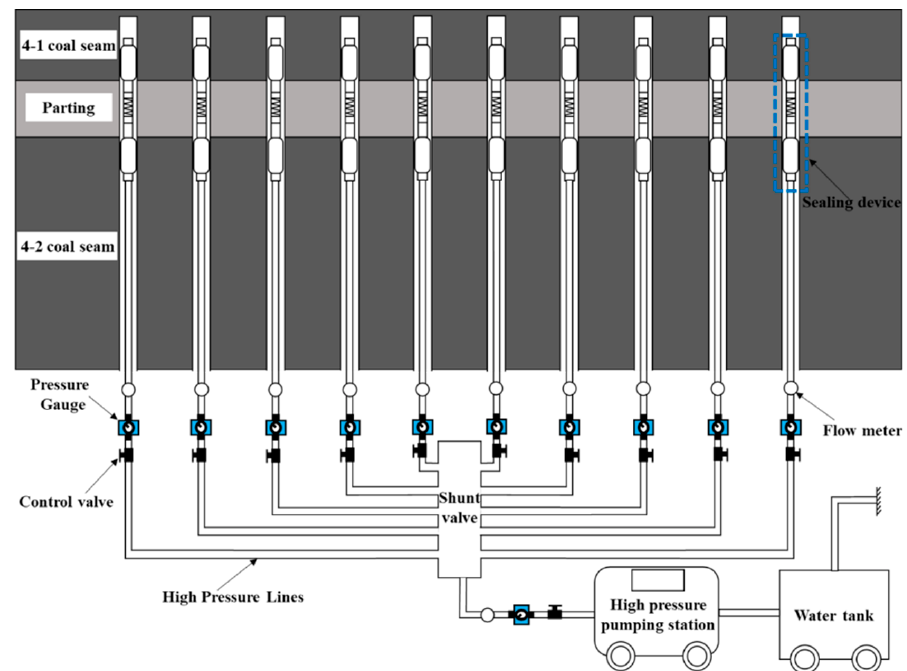
Figure 9. Schematic diagram of hydraulic fracturing process system layout of an ultra ‐ thick coal seam in fully mechanized caving face 42,108 with thick, hard, and high ‐ level gangue layers.